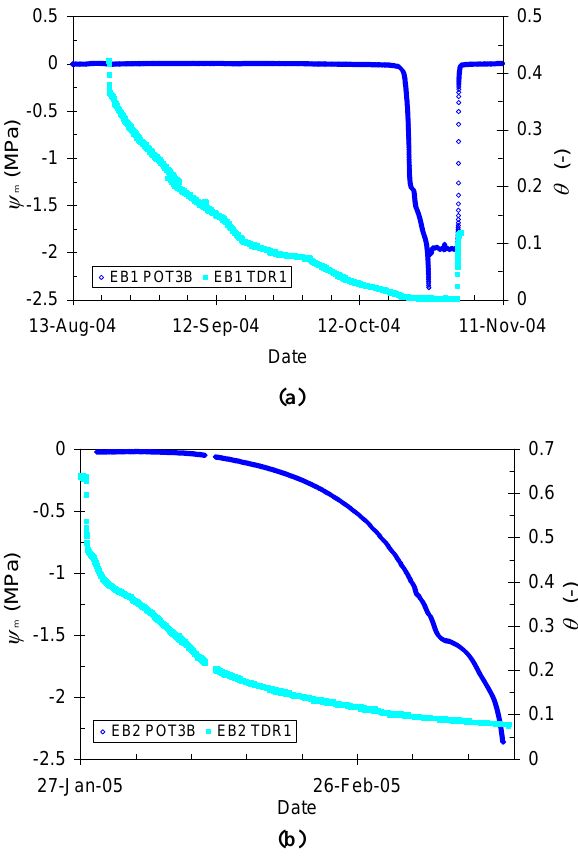
Fig. 3. Development of the matric potential ψ m of polymer ten- Figure 3. Development of the matric potential ψ m of polymer tensiometer 3B (POT3B) 529 siometer 3B (POT3B) and moisture content θ (TDR1) in time for and moisture content θ (TDR1) in time for evaporation box EB1 (a) and EB2 (b). 530 evaporation box EB1 (a) and EB2 (b) .